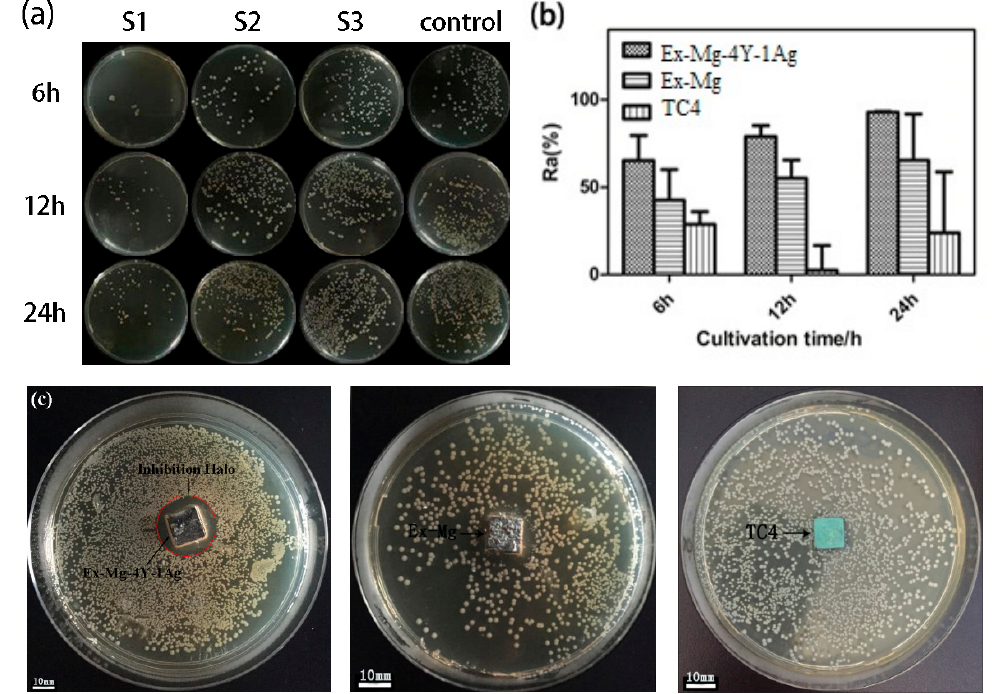
Figure 6. Results of bacteria counting and inhibition halo testing: ( a ) optical images of bacteria of three groups at 6 h, 12 h and 24 h, respectively; ( b ) graph of the antibacterial rate of three groups at 6 h, 12 h and 24 h; and ( c ) optical images of inhibition halo test for Ex-Mg-4Y-1Ag, Ex-Mg, TC4.